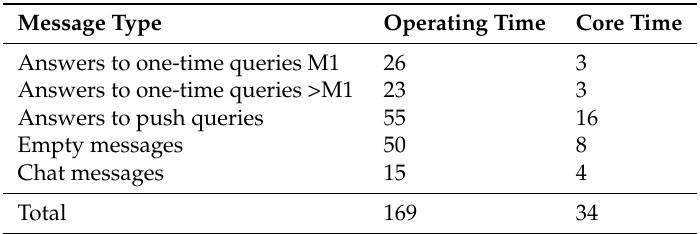
Table 5. Number of downlinked messages. In M1 messages, the answer fits into one single packet, while for >M1, it had to be split into several parts.